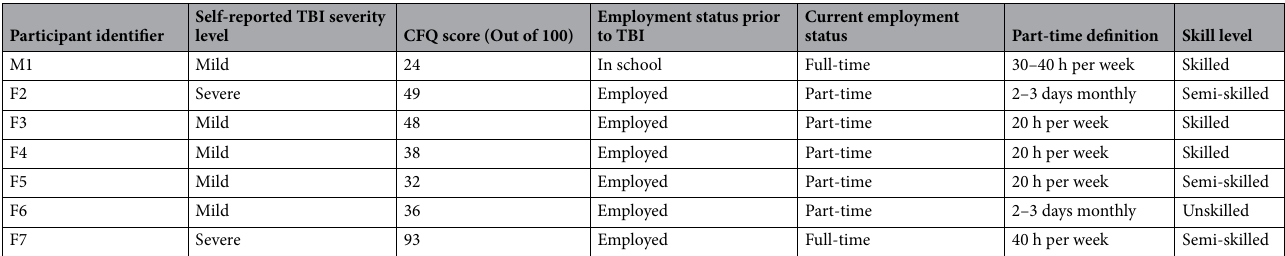
Table 1. Participant demographics. CFQ scores are cumulative and can range from 0 to 100 with a higher score indicating subjective cognitive difficulties. A high score is defined as a score ≥ 43.